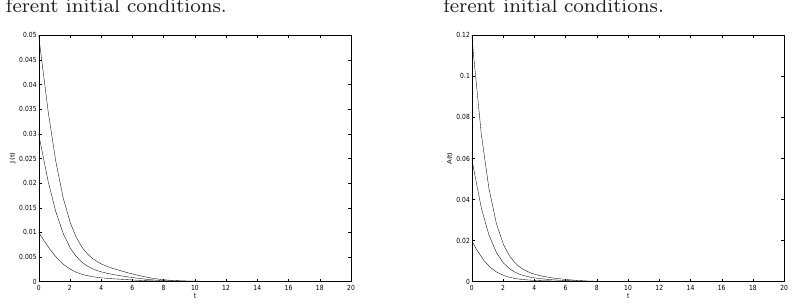
Figure 8. Trajectories of A(t) for dif- ferent initial